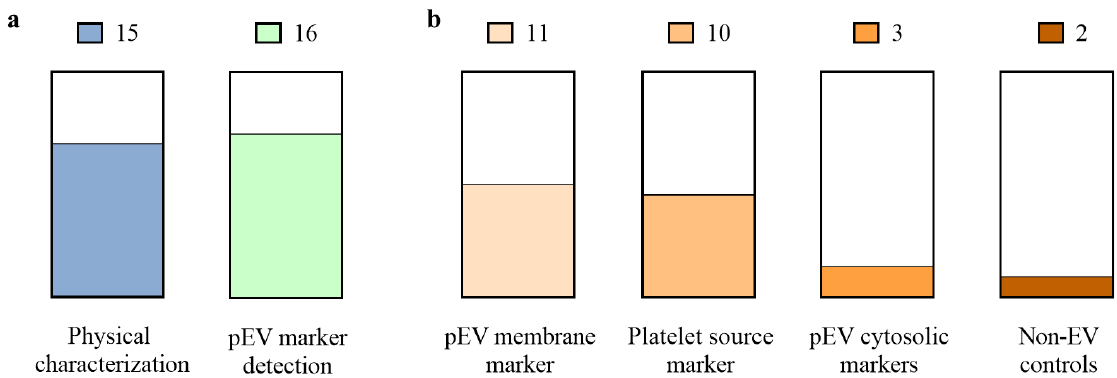
Figure 3. Characterization reported for pEVs used in regenerative applications. ( a ) Number of articles and the percentage of them which report physical characterization (include nanoparticle tracking analysis, electron microscopy, flow cytometry or dynamic light scattering), and pEV marker detection (include immunolabelling through western blot, flow cytometry or electron microscopy); ( b ) Number of articles and the percentage of them which report the different EV markers: pEV membrane marker (CD9, CD61, CD63 or CD81), platelet source marker (CD31, CD41 or CD42), pEV cytosolic markers (ALIX, TSG101, HSP90 or HSP101) and non-EV structures (APOA1, APOB100 or calnexin). A total of 22 articles were reviewed to obtain this data.